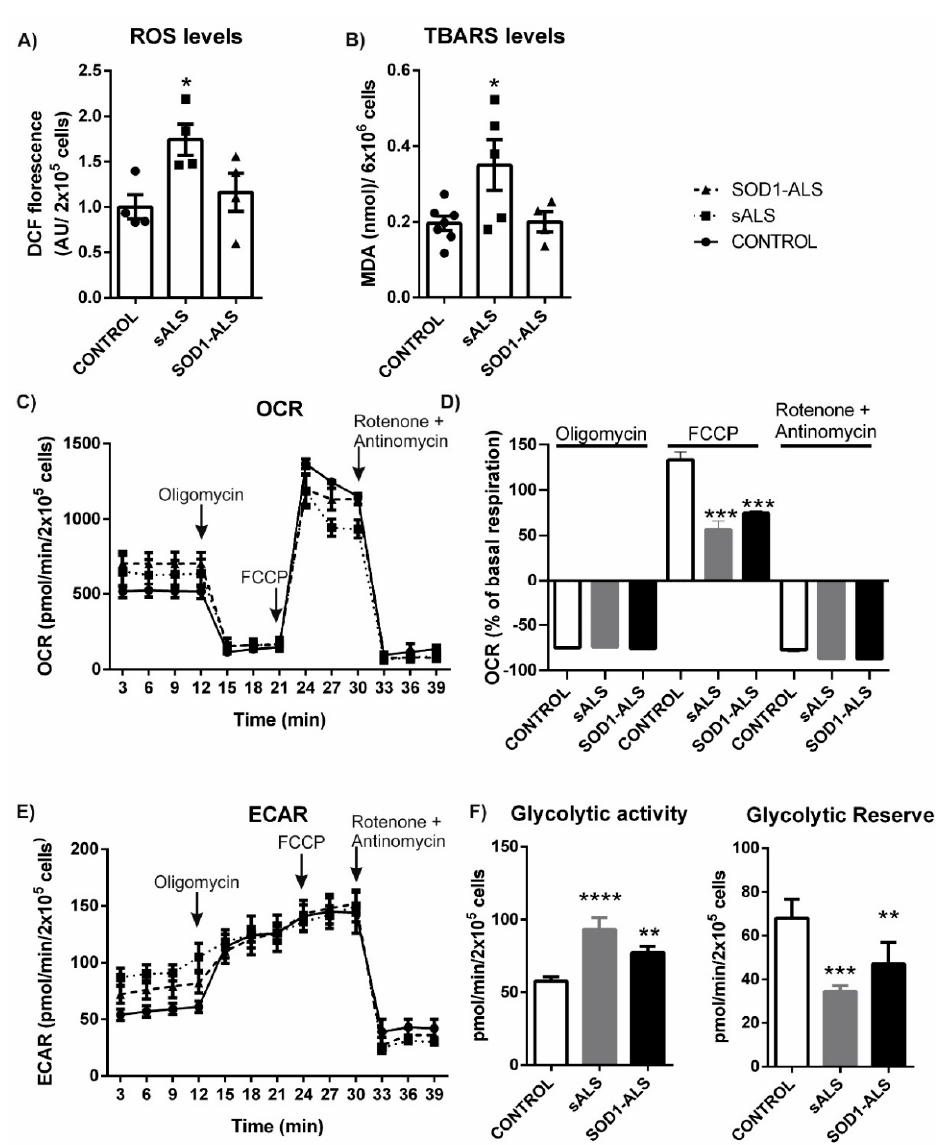
Figure 1. Reactive Oxigen Species (ROS) levels and bioenergetic profile of lymphoblasts derived from control individuals, sporadic ALS and SOD1- ALS. ( A ) Four lymphoblastoid cell lines from the three experimental groups were seeded at a concentration of 1 × 10 6 xml − 1 in RPMI medium containing 10% FBS for 24 h. Subsequently, about 200,000 cells were incubated with the CM-H 2 DCFDA probe for 30 min. The data show the mean ± the standard error of the mean of four LCLs in each group in three independent experiments. * p < 0.05. ( B ) Thiobarbituric acid-reactive substances (TBARs) representing malondialdehyde (MDA), resulting from oxidation of lipid substrates. Dots indicate the mean of n = 7 (controls), n = 5 (sALS), and n = 4 ( SOD1 -ALS) samples ± SEM. Asterisk denotes significant differences * p < 0.05, comparing the indicated groups with the basal condition according to a one-way ANOVA followed by Tukey post-test. ( C ) For these experiments, a pool was made with lymphoblasts derived from four control individuals and two more with lymphoblasts from four patients with sporadic ALS or SOD1 -ALS. 200,000 cells were seeded per well on the Seahorse XF24 Analyzer. The cells were cultured for 24 h, before measurements were made in an unbuffered DMEM medium at pH 7.4 containing pyruvate at 1 µM and glucose at 25 µM. The graph represents the respiration of control cells and ALS cells over time and the effect of the addition of 1 µM oligomycin, 3 µM FCCP and 1 µM rotenone + 1 µM antimycin. The data show the mean of four experiments ± the standard error of the mean. ( D ) Percent change in mitochondrial respiration in response to mitochondrial inhibitors. Bars represent the mean change in OCR from baseline ± SEM (*** p < 0.001 as compared with control). ( E ) Temporal assessment of extracellular acidification rate (ECAR). ( F ) Quantitative measurement of glycolytic capacity and glycolytic reserve (change in ECAR after oligomycin injection) respectively. ** p < 0.01; *** p < 0.001; **** p < 0.0001.